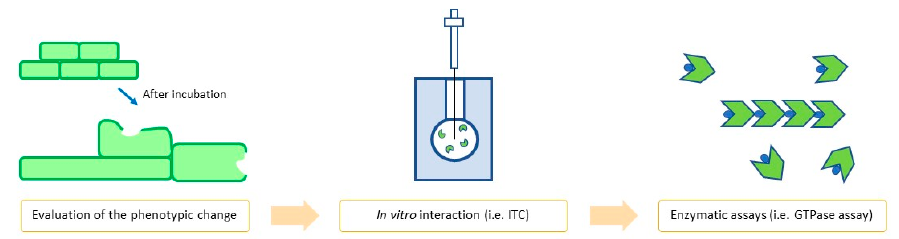
Figure 2. Flowchart of the main steps in FtsZ inhibition confirmation.